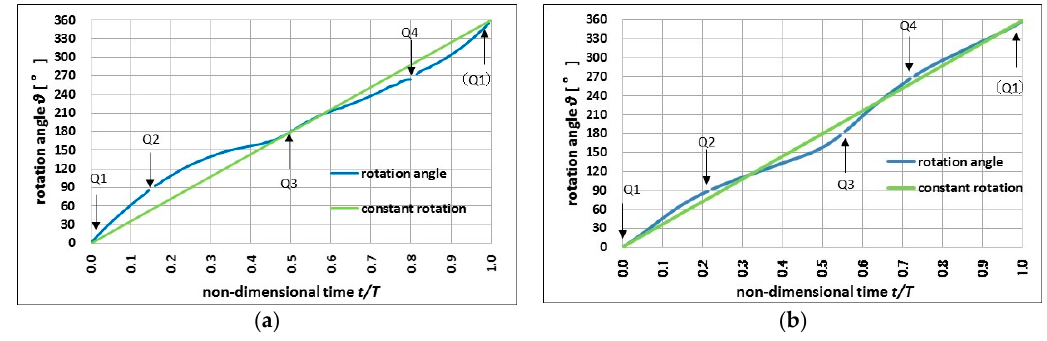
Figure 3. Time history of rotation angle around the body axis. ( a ) Gymnast A; ( b ) Gymnast